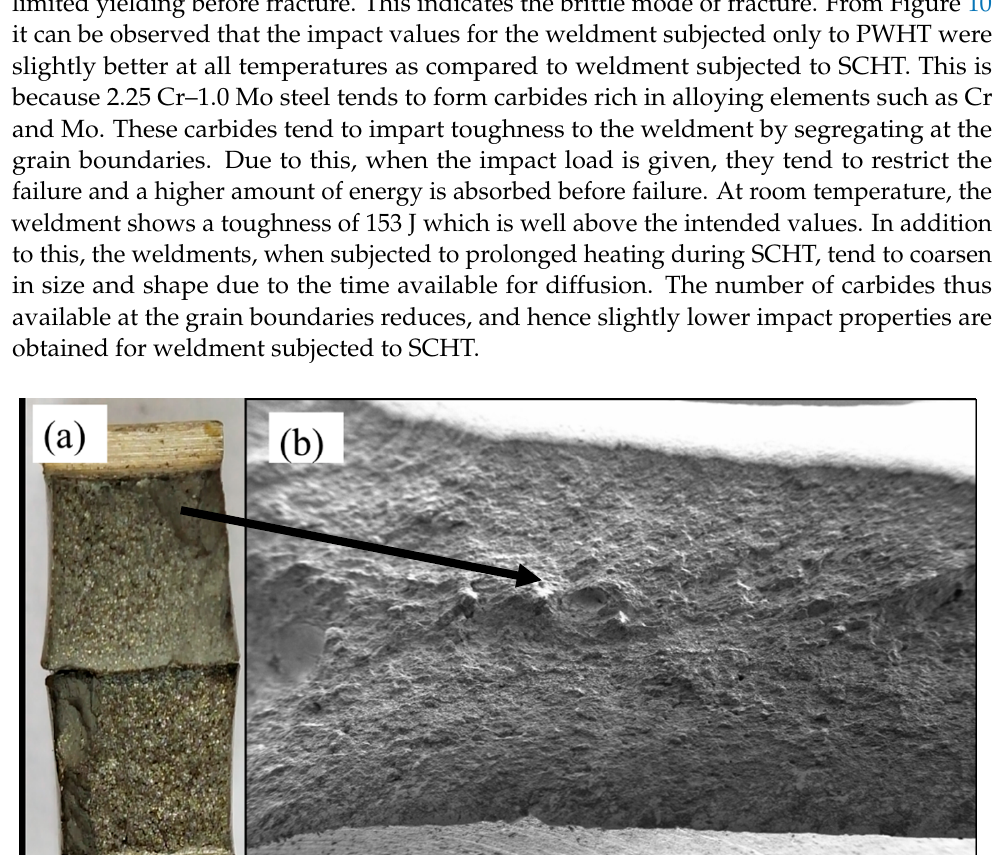
Figure 10. Impact toughness values and DBTT curves. To determine the susceptibility of the weldment for temper embrittlement, the duc- tile-to-brittle transition curves were sketched, as shown in Figure 10, such that they passed through the maximum points on the graph. It can be observed that the curve has shifted toward the right side which is for the weldment subjected to SCHT. The temperature at which the transition from ductile to brittle takes place is calculated by drawing a line at 55 J which is the requirement as per API 934A. This indicates the temperature to which the component can work safely without getting fractured due to embrittlement. The DBTT concept pertains to the fact that the weld microstructure of the equipment after years of operation (thermal cycles) undergoes a transition from the ductile mode to brittle mode. This is true with respect to a temperature after which there is a sharp fall in the ductility. Here, the DBTT value indicates the approximate temperature at which the equipment will not be able to have minimum required impact values (55 J) after undergoing SCHT. If DBTT values are lower than the working temperature of equipment, it is considered safe to use. Hence, lower temperatures of DBTT would indicate favorable results as equipment working temperature is generally above 0 °C [38]. It can be observed that the transition temperature value for weldment that has un- dergone PWHT (TT55) is − 45 °C whereas the value for weldment with SCHT is (TT55SC) − 37 °C. This result can be considered as a major outcome of the study as it proves the